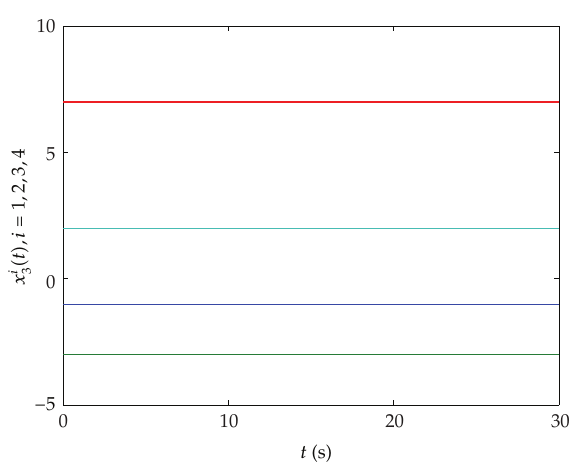
(cid:6) t (cid:7) , i (cid:9) 1 , 2 , 3 , 4. 2